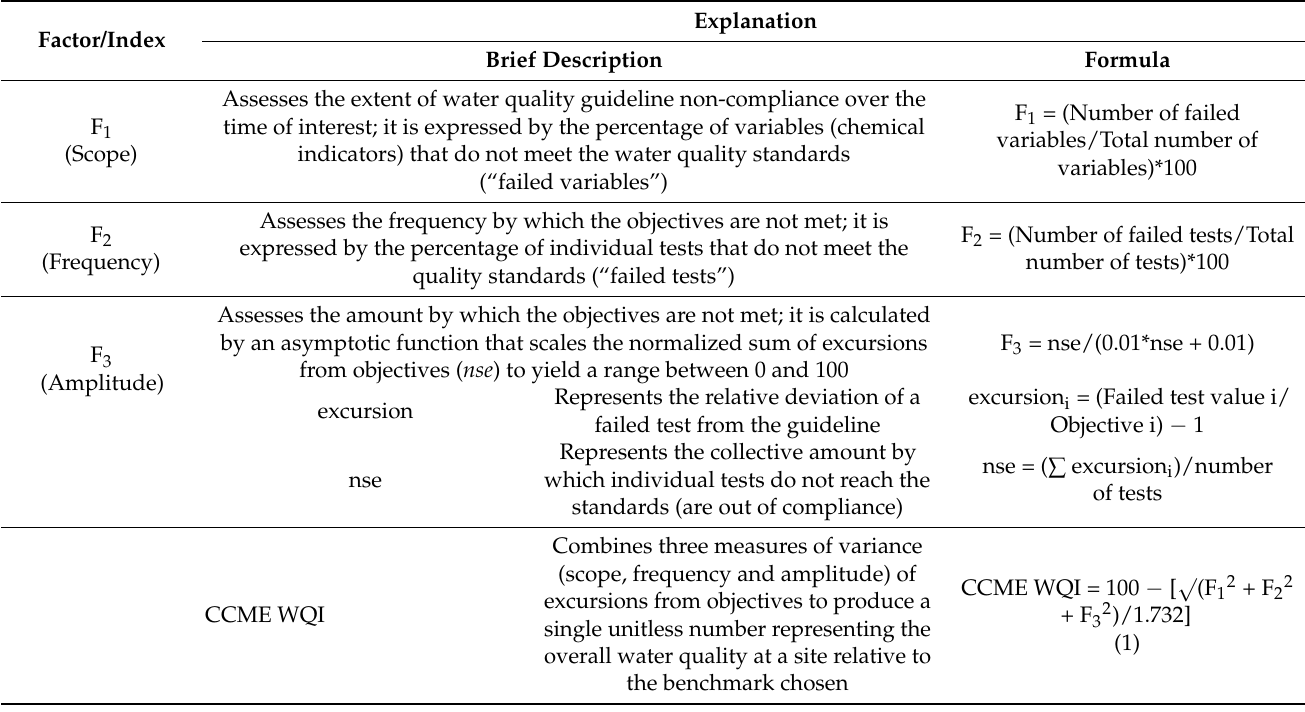
Table 3. Detection Parameters for CCME WQI evaluation [22,23,26].